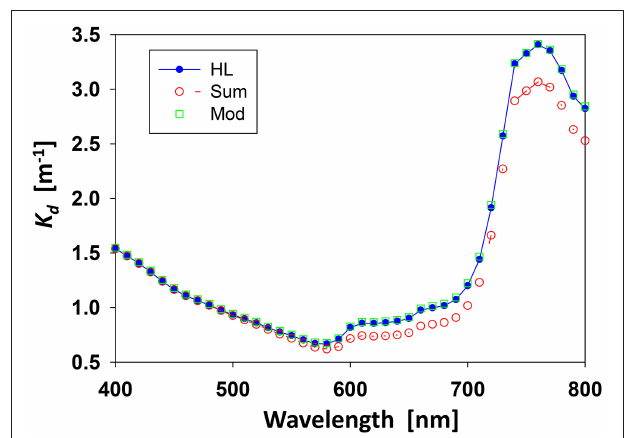
FIGURE 1 | Comparison of K d spectra between Hydrolight simulation (blue), sum of individual components (red), and that from semi-analytical model based on bulk IOPs (green). The range for K d is between surface and